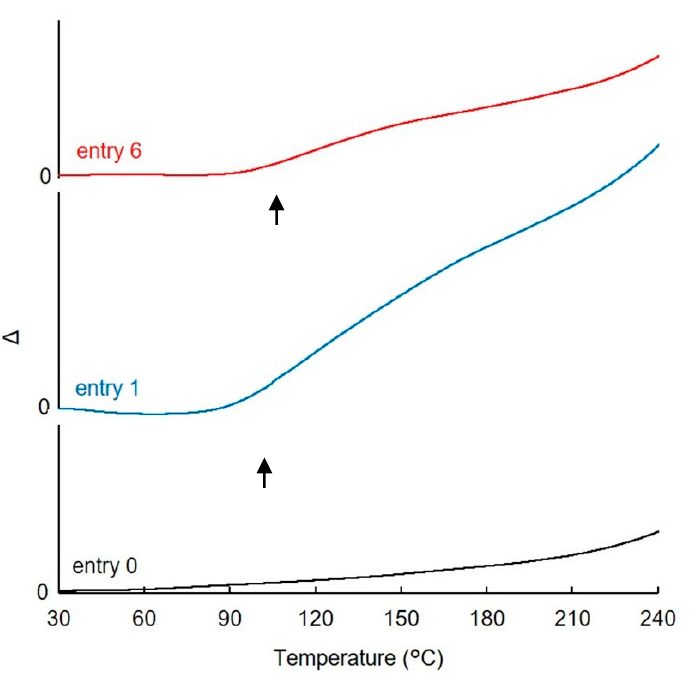
Figure 9. TMA thermograms of degreased wood (entry 0) and benzylated woods (entry 1 and 6). Arrows indicate the thermal softening points.